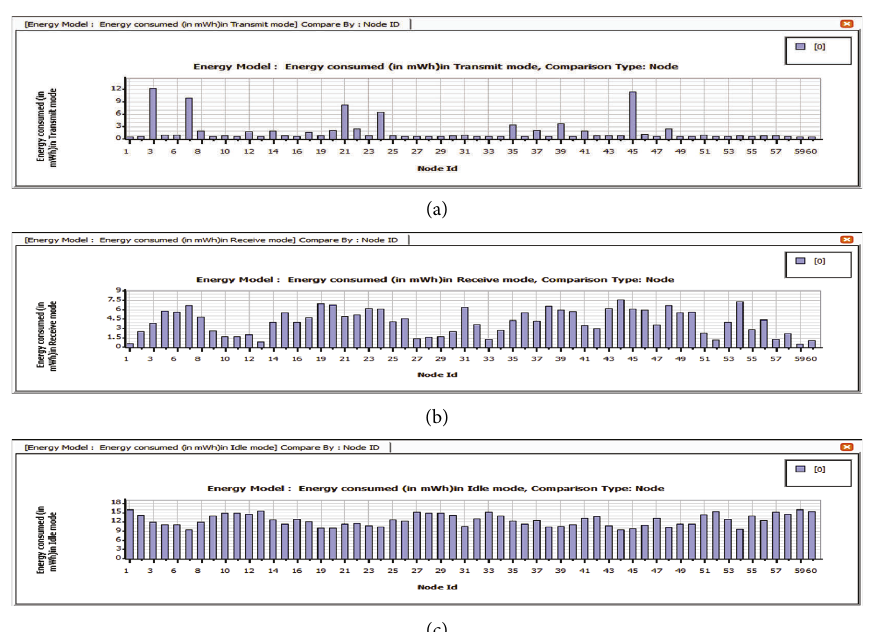
Figure 22: (a) Transmit mode energy consumption of OLSR for VBR deployment. (b) Receive mode energy consumption of OLSR for VBR deployment. (c) Idle mode energy consumption of OLSR for VBR deployment.